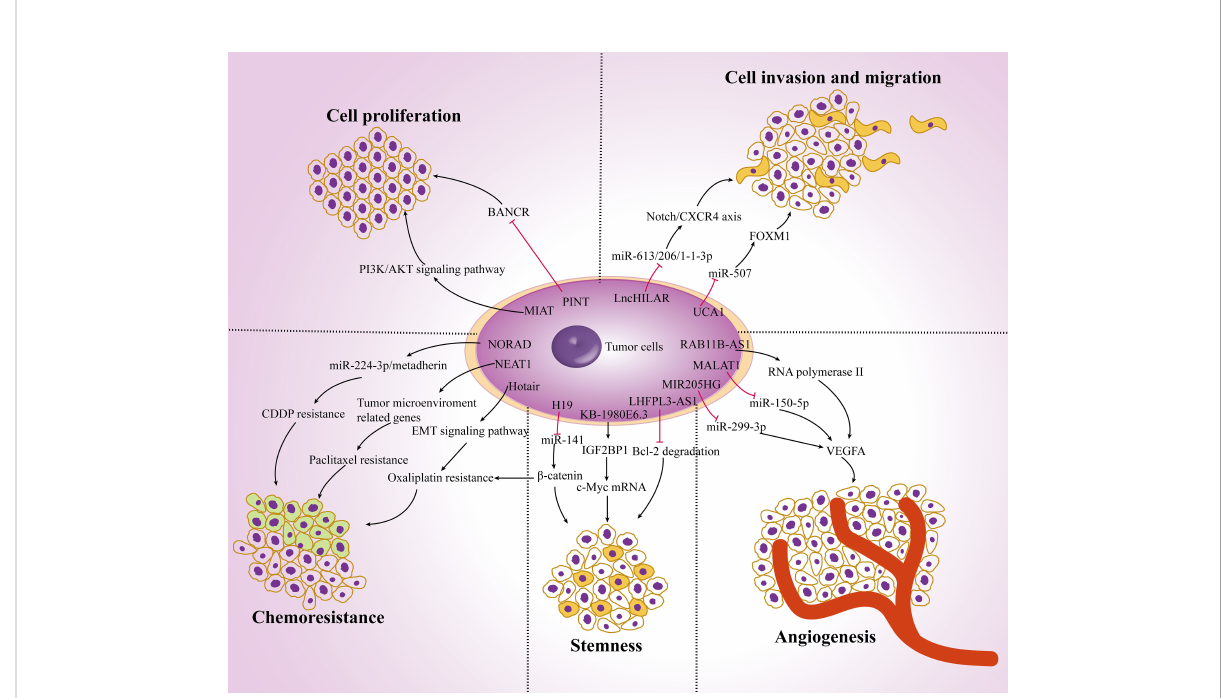
FIGURE 1 The role of lncRNAs in carcinogenesis. Dysregulation of lncRNAs in melanoma cells affects tumor cell proliferation, invasion and migration, angiogenesis, stemness and chemoresistance by targeting multiple genes and ultimately regulate tumor